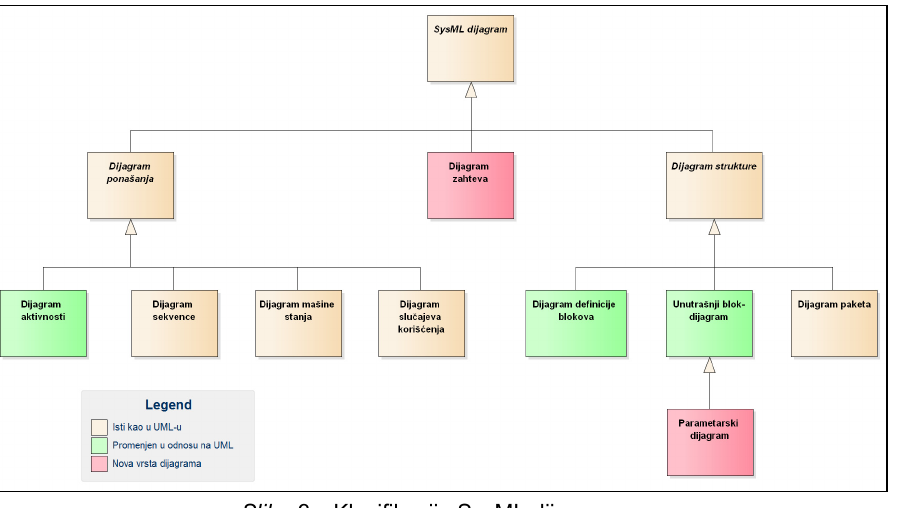
Рис . 2 – Диаграмма классификации SysML Figure 2 – SysML diagram classification